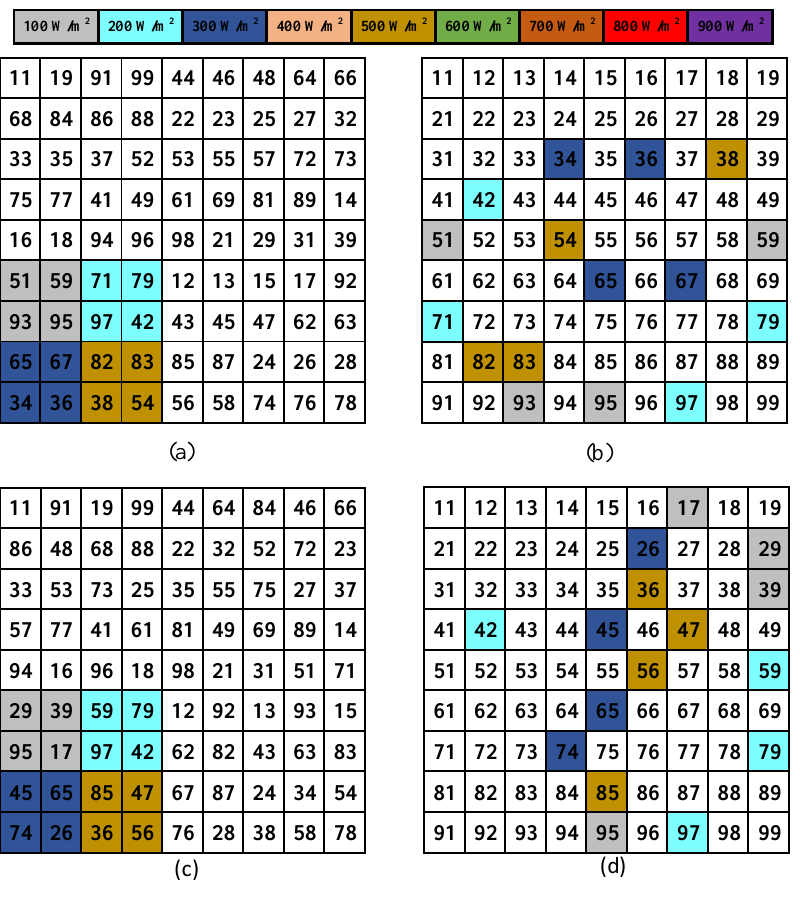
Figure 6. ( a ) OEP; ( b ) shade dispersion of OEP; ( c ) IOEP; ( d ) shade dispersion of IOEP for 9 × 9 PV array at Bottom-Left PSC.